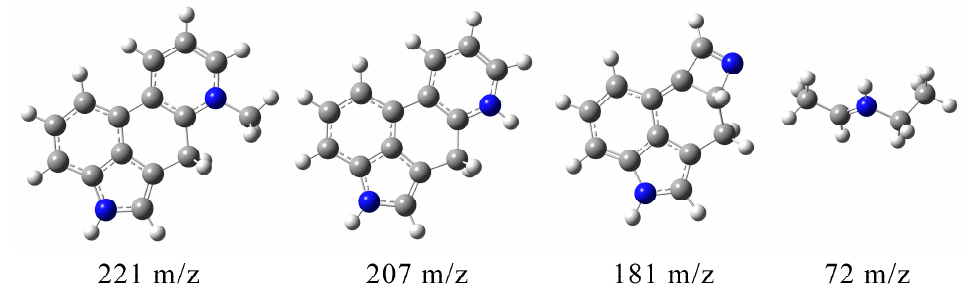
Figure 4. Optimized structures (at M05-2X/6-311++G(d,p) level of theory) of the most abundant fragments in the mass spectrum of LSD.